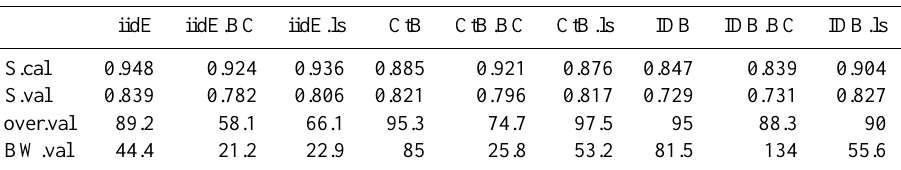
Table 1. Prediction performance metrics for the different error models: iid untransformed error model (iidE), Box–Cox transformed (iidE.BC), and log-sinh transformed (iidE.ls), constant untransformed bias (CtB), Box–Cox transformed (CtB.BC), and log-sinh transformed (CtB.ls), input-dependent untransformed bias (IDB), Box–Cox transformed (IDB.BC), and log-sinh transformed (IDB.ls). The criteria on the left represent the Nash–Sutcliffe index in calibration (NS.cal) and validation (NS.val) phases in the non-transformed space, the percentage of validation data points falling into 95% prediction interval (Cover.val), and the average bound width [Ls − 1 ] in the extrapolation domain (ABW.val).